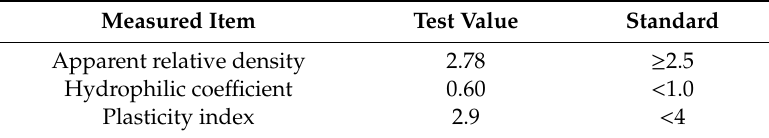
Table 4. Technical properties of mineral powder of ground limestone.